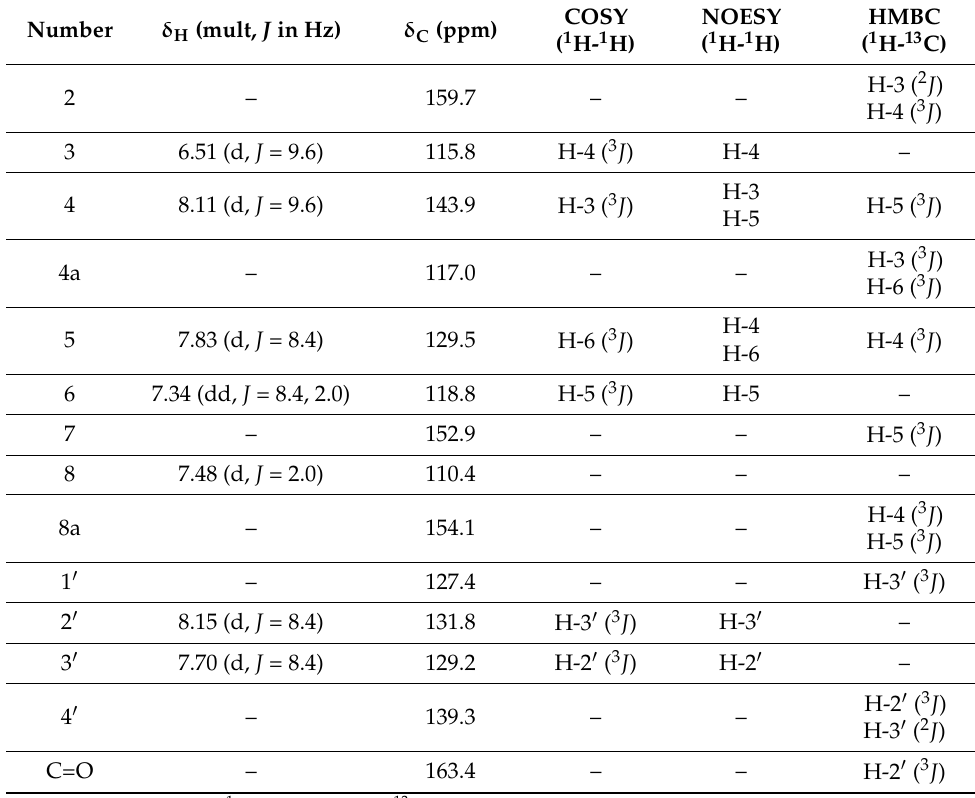
Figure 2. ( A ) Structure of 2-oxo-2 H -chromen-7-yl 4-chlorobenzoate 3 . ( B ) Connectivities of 3 based on COSY (bold red line) and HMBC (from H to C, blue arrow) data. Table 1. 1 H and 13 C{ 1 H} NMR assignments, and COSY, NOESY, and HMBC correlations of 3 a